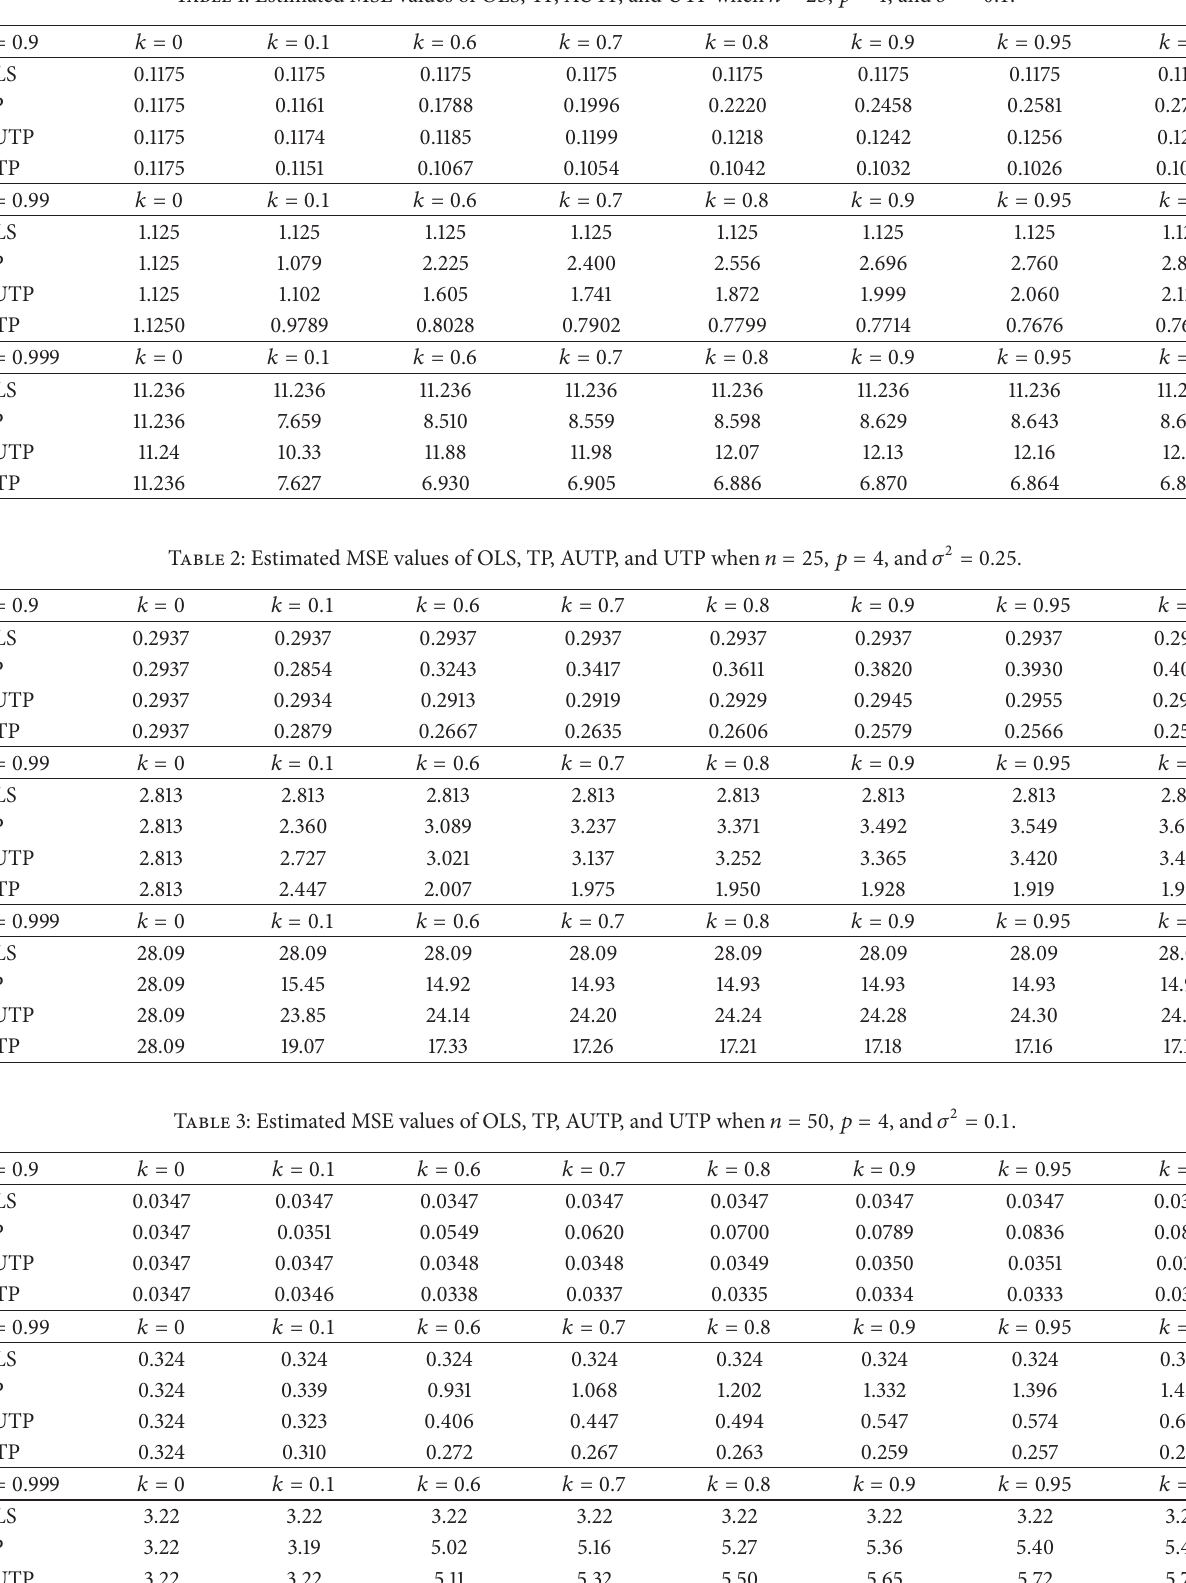
Table 1: Estimated MSE values of OLS, TP, AUTP, and UTP when 𝑛 = 25 , 𝑝 = 4 , and 𝜎 2 = 0.1 .